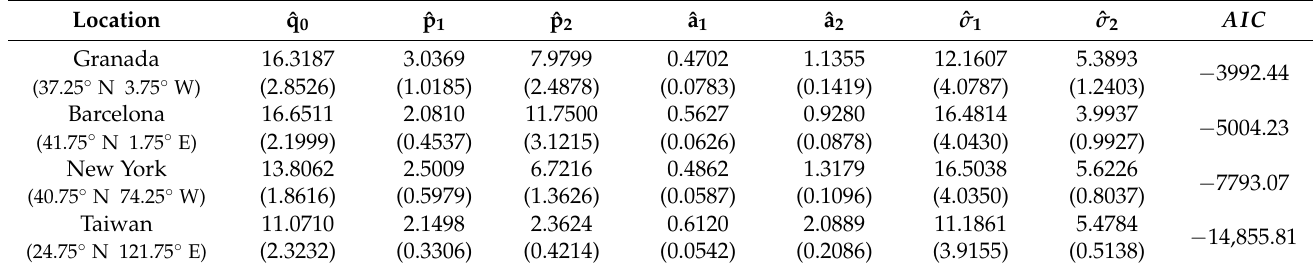
Table 2. Parameter estimates and AIC statistics, from the bivariate GB2 model with q fixed (Equation (11)), to the four bivariate truncated datasets by maximum likelihood, with standard errors in parenthesis ( pr expressed in 10 − 4 kg · m − 2 · s − 1 and sfcWind expressed in m · s − 1